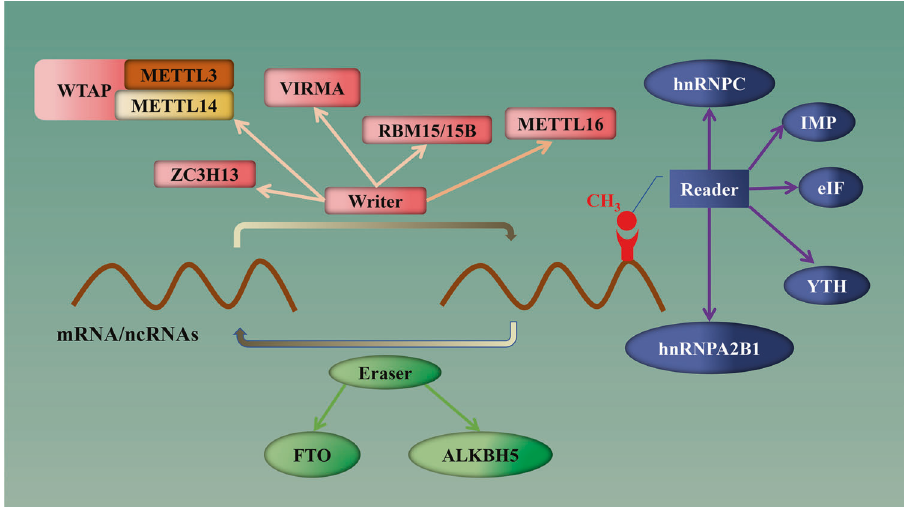
Fig. 1 Classi fi cation diagram of m6A regulators. According to their regulatory functions, m6a regulators can be divided into Writers, Erasers and Readers. Writers (including METTL3, MTTTL14, WTAP, etc.) mainly play the role of methylation modi fi cation, while Erasers (including ALKBH5, FTO, etc.) mainly play the role of demethylation modi fi cation. Readers (including YTH family factors, IMP factors, eIF factors, etc.) mainly recognize methylated bases and play a regulatory role.